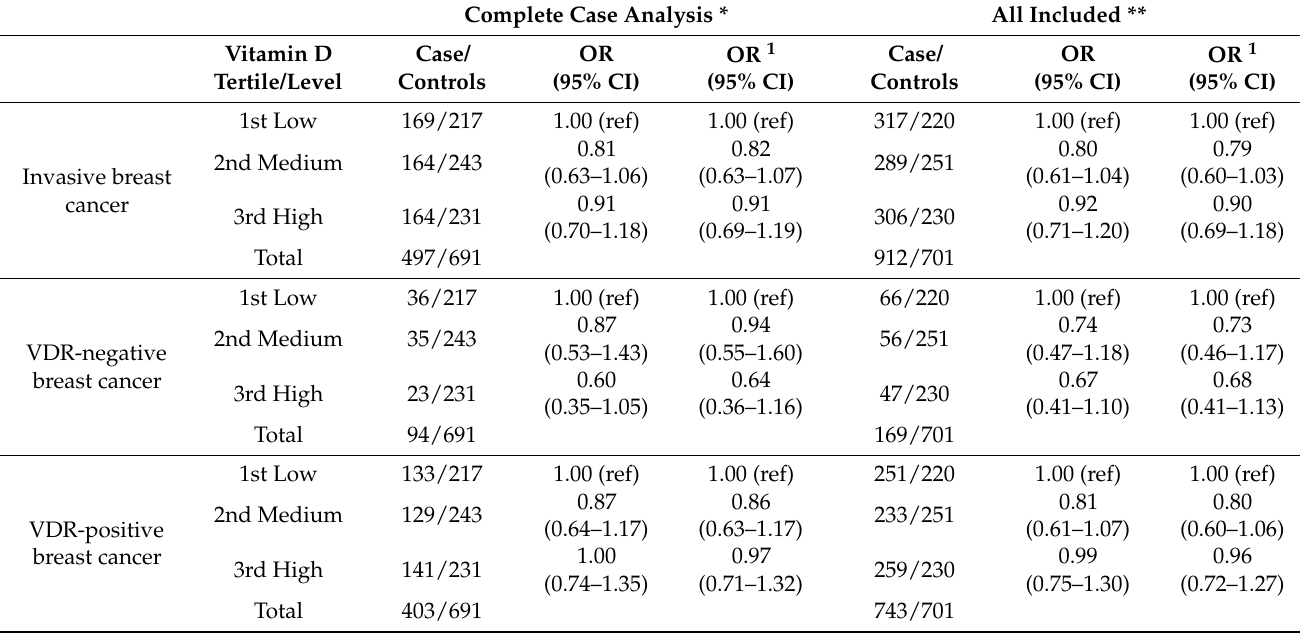
Table 2. Levels of vitamin D in relation to risk of breast cancer overall, or risk of VDR neg/pos breast